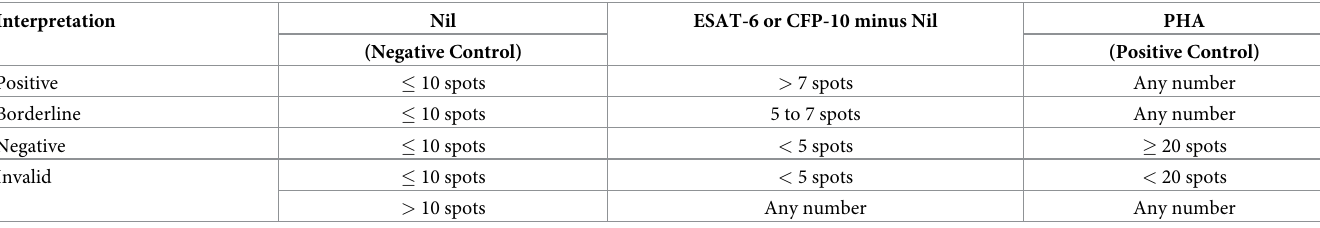
Table 1. Interpretation of T-SPOT TB results based on spot-forming cells